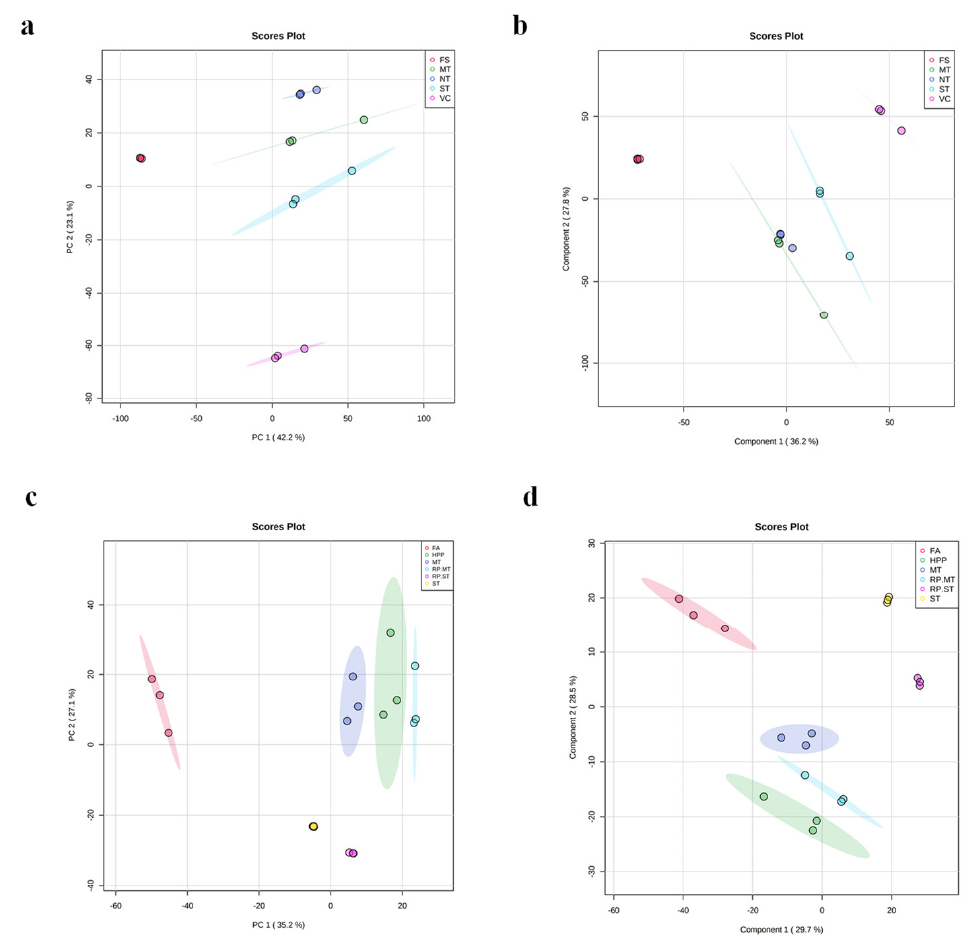
Figure 1. PCA and PLS-DA model plots. Strawberry: ( a ) PCA plot, ( b ) PLS-DA plot. Apple: ( c ) PCA plot, ( d ) PLS-DA plot. Strawberry samples: Fresh strawberries (FS), No heat treatment (NT), mild heat treatment (MT), standard thermal treatment (ST), vacuum concentration (VC). Apple samples: Fresh apple (FA), high-pressure processing (HPP), mild heat treatment (MT), standard thermal treatment (ST), reprocessed mild heat treatment (RP.MT), reprocessed standard thermal treatment (RP.ST).